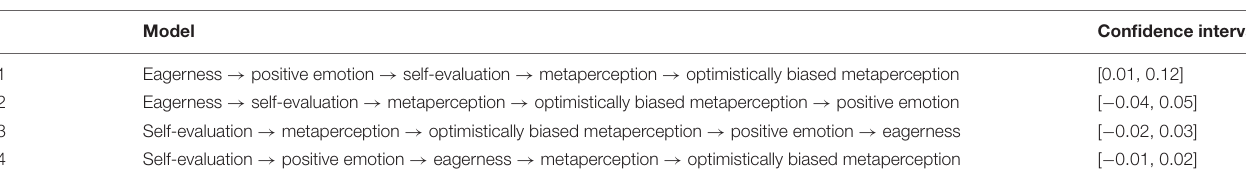
TABLE 3 | Multiple pathways (Study 2). Model Confidence